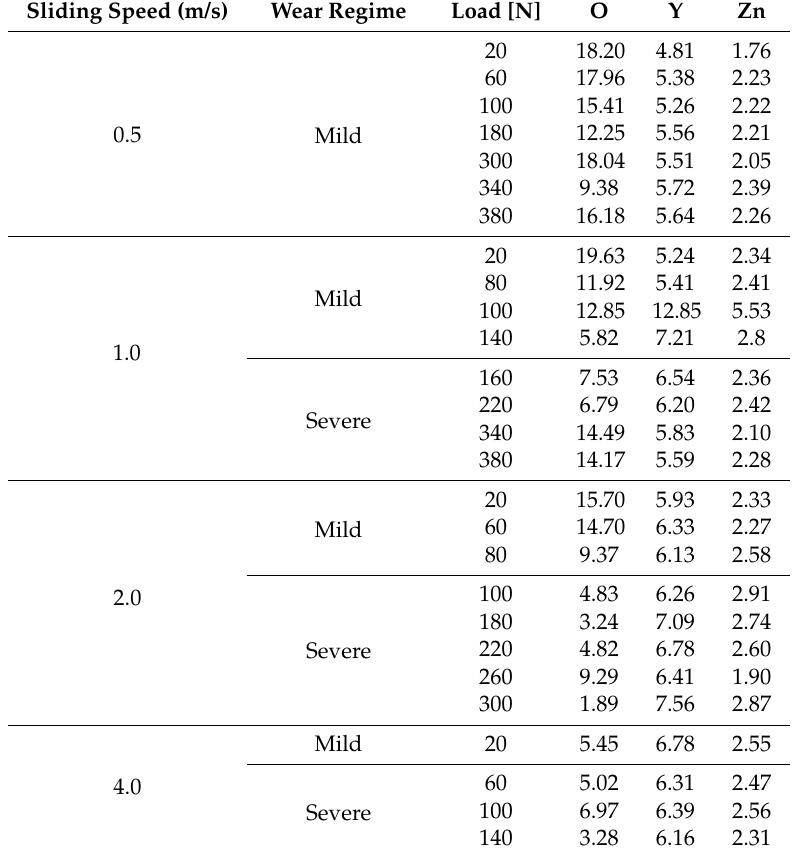
Table 3. Chemical composition analysis of worn surfaces under different sliding conditions (wt %). Sliding Speed